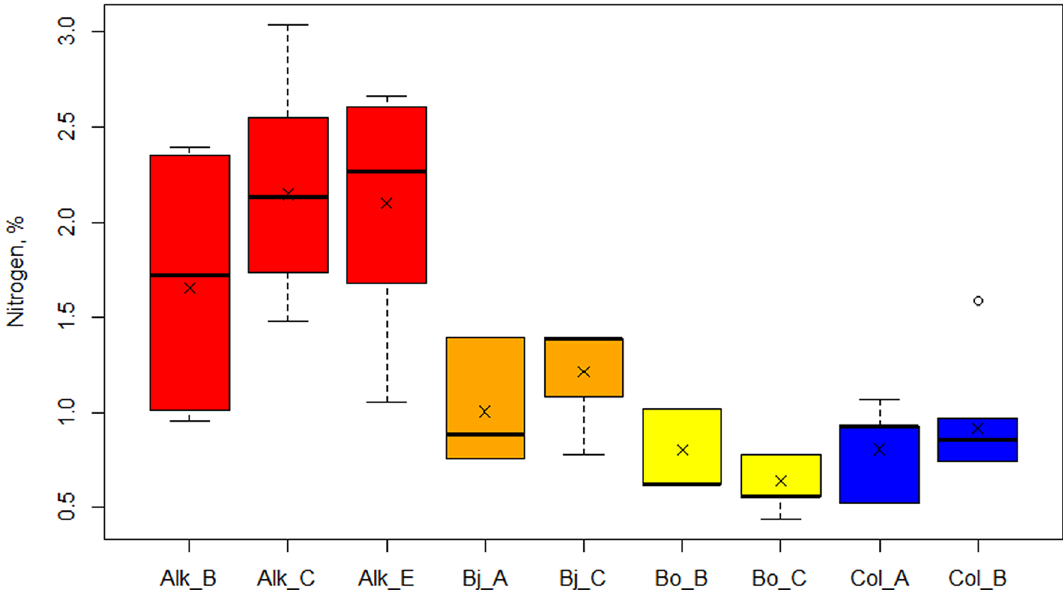
Figure 10. Nitrogen content (%) for the focus section study points. The × marks mean value and the vertical line median value. Where applicable, whiskers represent 1st and 3rd quartile. Outliers are shown as dots outside the